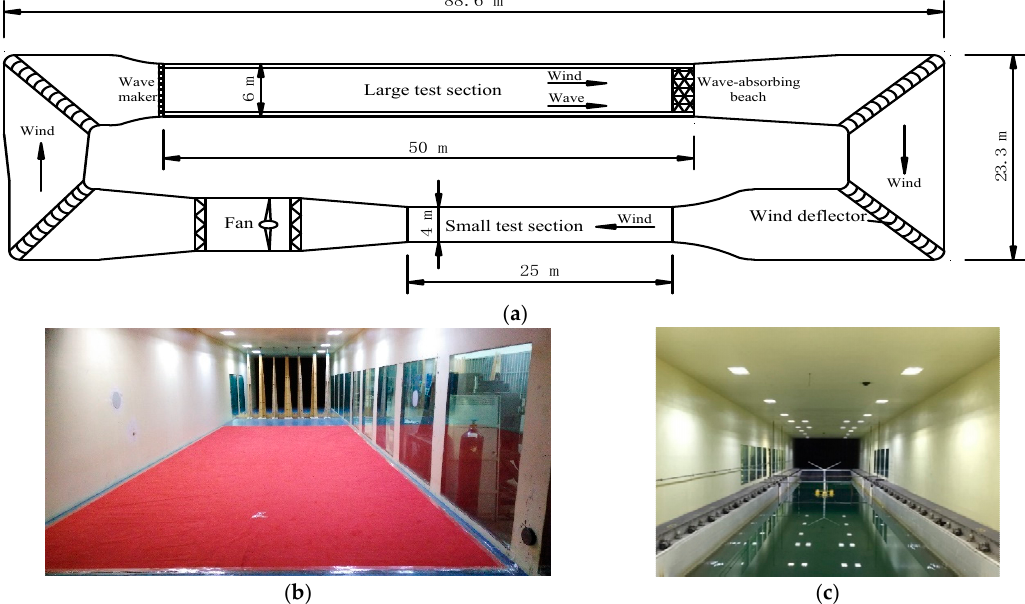
Figure 2. The wind tunnel and wave flume joint laboratory: ( a ) Plane diagram; ( b ) Small test section; ( c ) large test